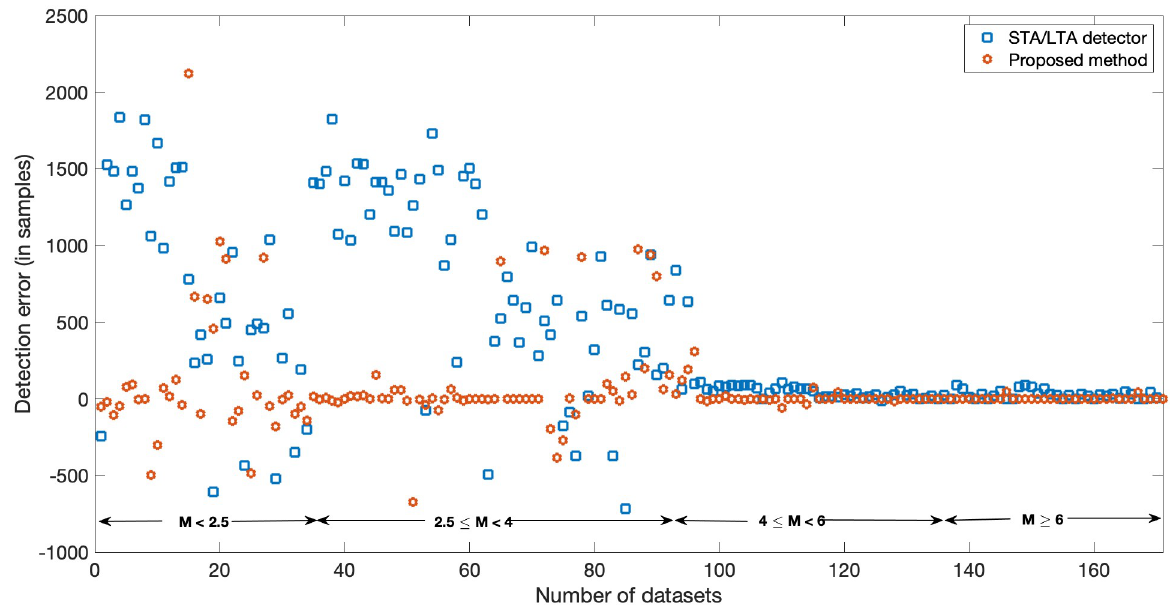
Fig 13. Comparison with existing detector. Detection error in samples of STA/LTA and the proposed method for events of different magnitude range. https://doi.org/10.1371/journal.pone.0250008.g013 respectively, with an accuracy of less than 5 sec. DWT-AIC picker picks 54% of the later phases while the AIC picker picks only 39%. The proposed method picks 56% of the P-wave arrival with high accuracy ( < 0.05 sec) while picking 33% with an accuracy of 2.5 sec. The proposed method fails to pick only 11% of the arrivals. For higher magnitude events (category 3: